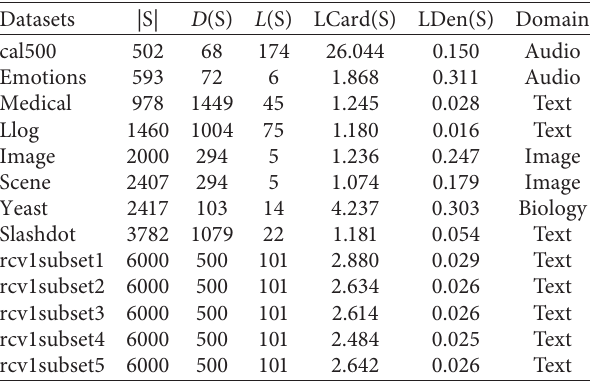
Table 1: Properties of the experimental